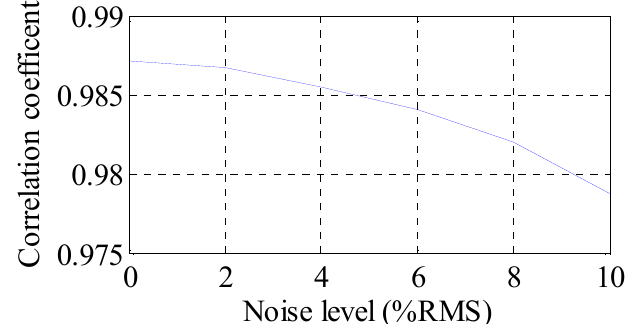
Figure 12. Reconstruction performance measured in correlation coefficient under different noise levels.